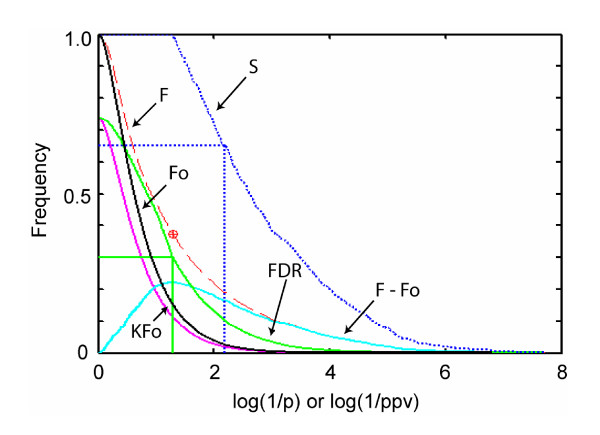
Selection abacus. The following functions of x are displayed: F (red dashed curve), KFo (magenta continuous curve), FDR (green continuous curve) and S (blue dotted curve). The crossed circle marks the position at which the maximum of F-Fo (cyan continuous curve) is detected. Interpolation on the FDR curve shows that FDR~30% at S = 100% (green continuous straight lines). Similarly, interpolation on the S curve shows that S~65% at FDR = 10% (blue dotted straight lines). Abscissa x could be either log10(1/p-value(zRD)) in the case of a simple comparison or log10(1/ppv) if replicates are used. All the curves are constrained to be strictly decreasing functions except F-Fo.